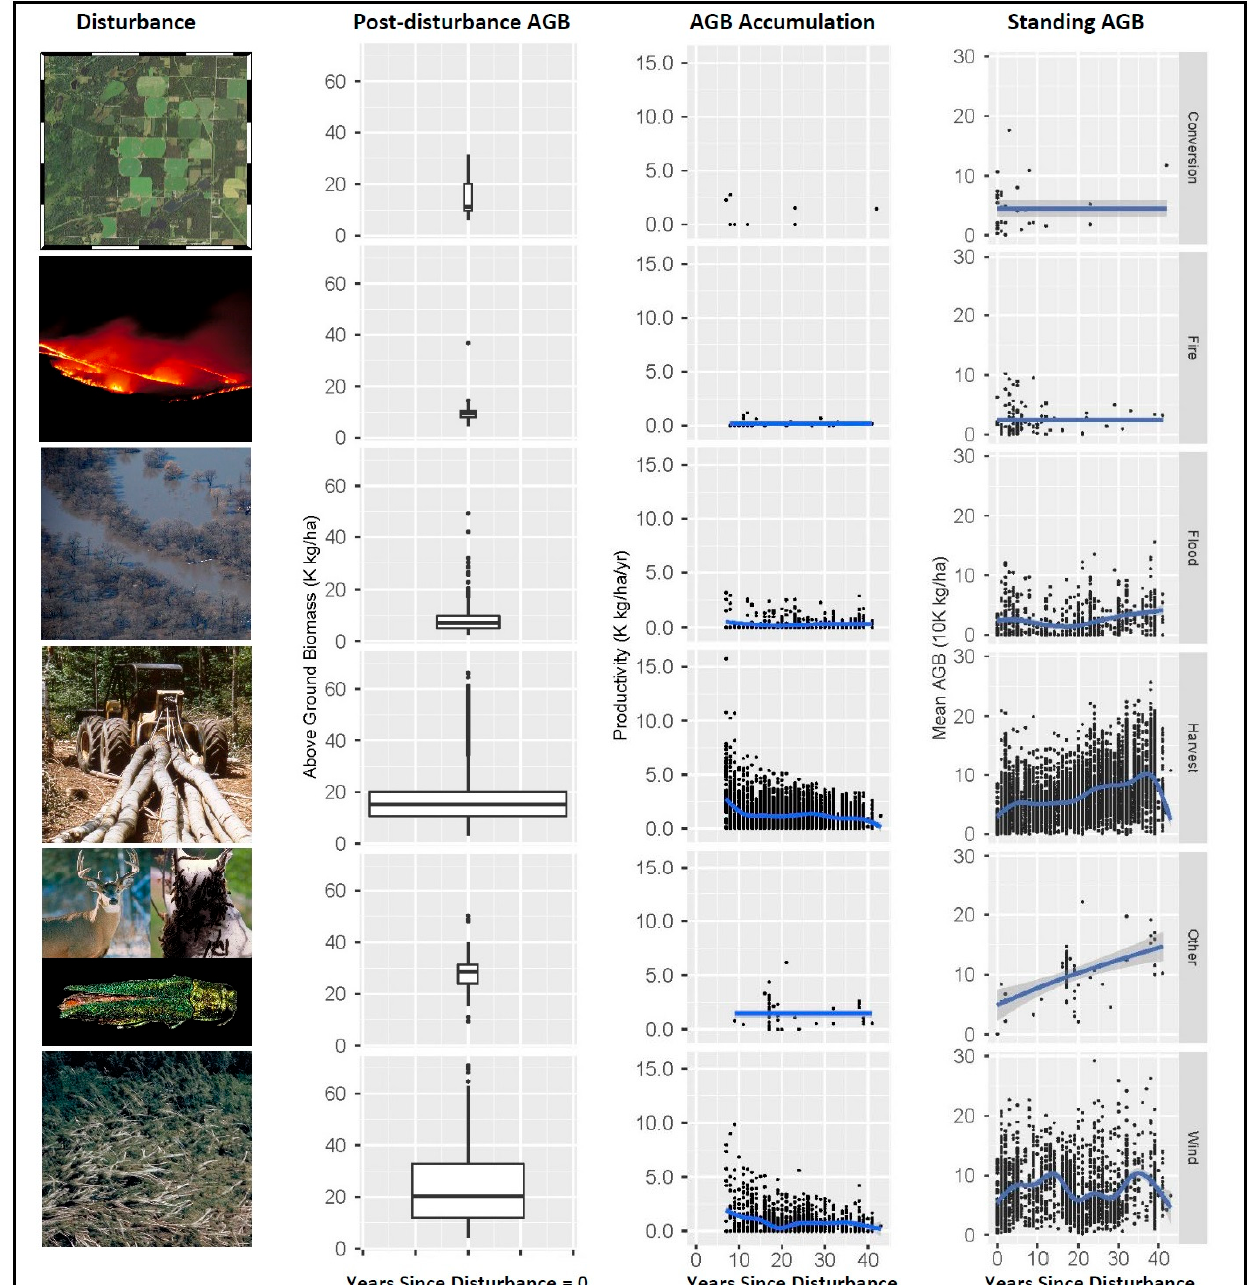
Figure 4. Summary of initial above ground biomass following different disturbances, subsequent AGB accumulation rates, and standing AGB over time. Image credits: MNDNR, USGS. Non-significant comparisons included conversion and fire, conversion and flood, and fire and flood (Table 5). Statistics for estimates of productivity between 5 and 15 years after disturbance are shown in Table 6. A pairwise t-test (with Bonferroni adjustment) of between group differences in biomass accumulation over time showed that there was a statistically significant difference ( α = 0.05) between harvest and fire, between harvest and flood, and between harvest and wind. Significant differences in biomass productivity over time also existed between fire and other, flood and other, wind and other, and between wind and flood (Table